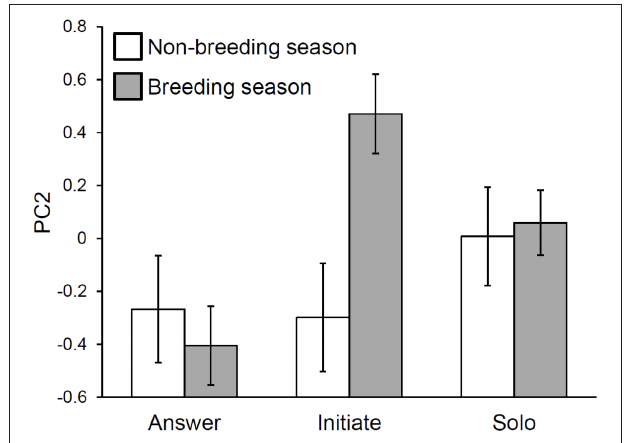
FIGURE 4 | An interaction between singing role and season explains variation in troupial song composition. Composition PC2 measures syllable diversity and average minimum path length between syllable types. Seasonal differences in initiating songs are the primary driver of the interaction effect. Bars represent least squares means with standard error